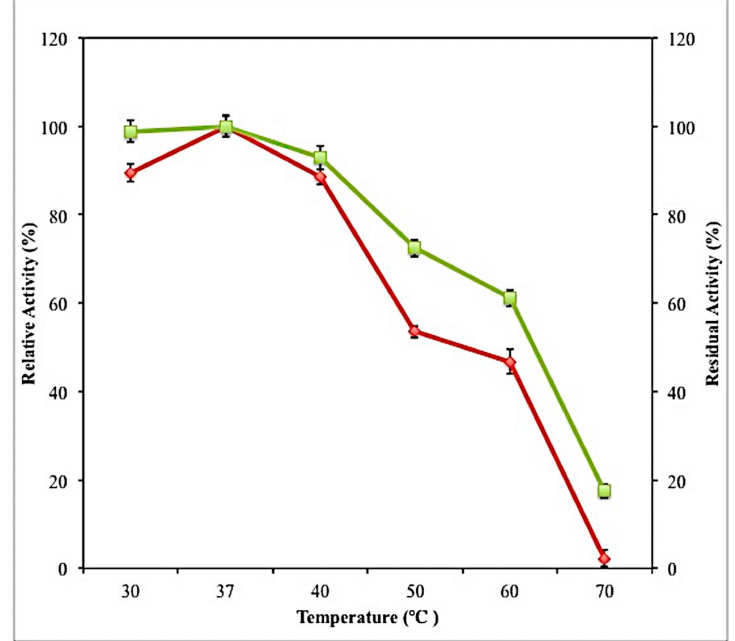
Figure 7. Effect of temperature on the activity ( (cid:7) ) and stability ( (cid:4) ) of lipase produced by L. mesenteroides subsp. mesenteroides ATCC 8293. Enzyme activity was determined by assaying its activity at temperatures ranging from 30–70 ◦ C Enzyme stability was investigated by incubating the enzyme at various for 1 h at pH 8, in 50 mM Tris-HCl Buffer. All the assays were conducted in triplicate and the average values were